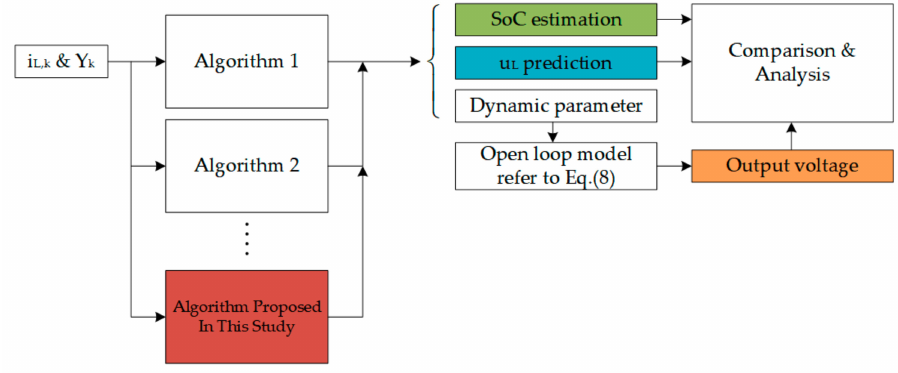
Figure 11. Structure of algorithms comparison